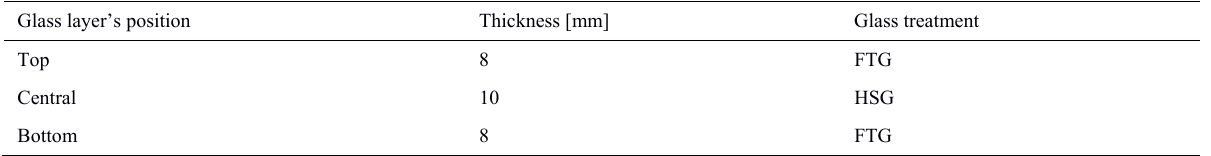
Table 1: Composition of the laminated glass floor.